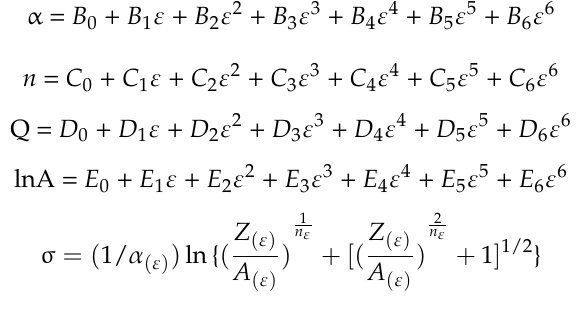
Table 1. The sixth-order polynomial fitting coefficients of each material constants.